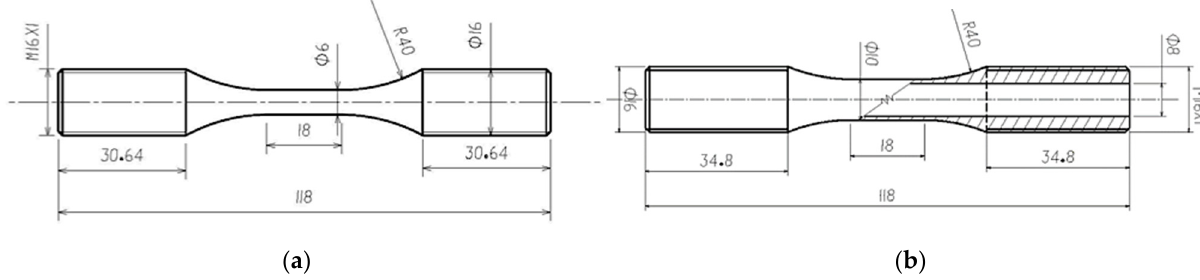
Figure 1. ( a ) Solid specimen and ( b ) tubular specimen with 1 mm wall